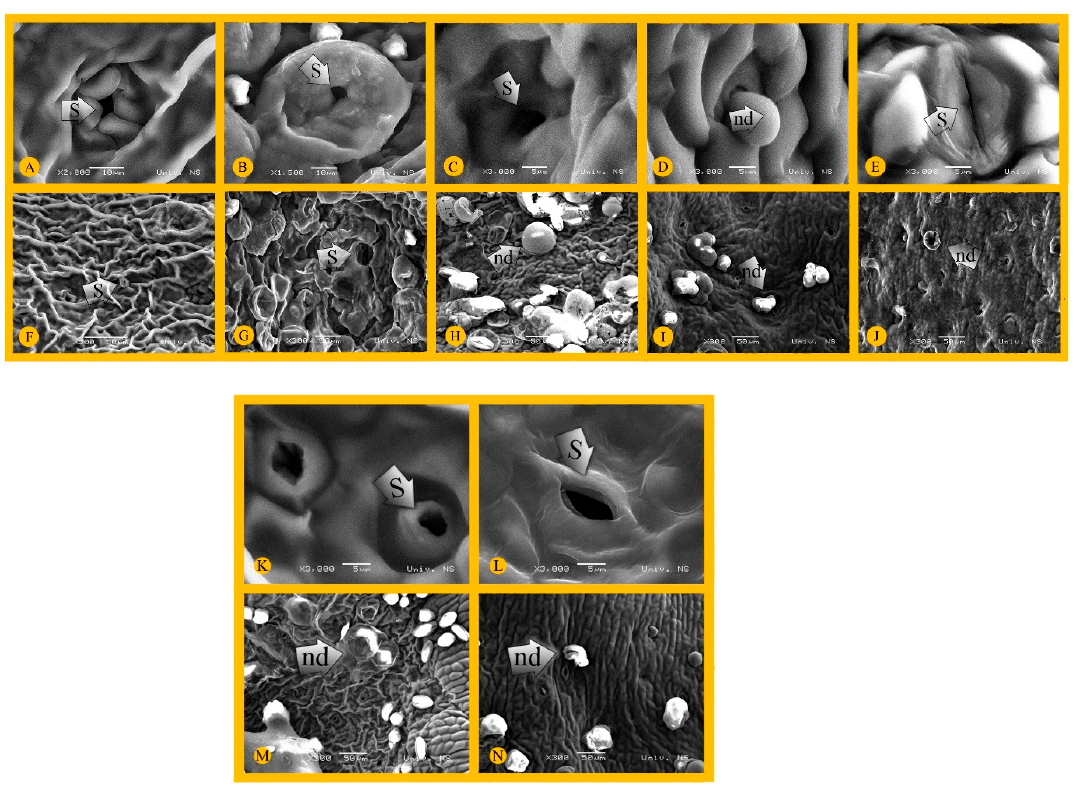
Figure 5. SEM micrographs of the nectary surface showing epidermis covered with cuticle focused on enlarged modified stomata in five cultivars comparatively: ( A , F ) Alexander Lucas (low susceptible), ( B , G ) Kieffer (highly resistant), ( C , H ) Nijisseiki (highly resistant); ( D , I ) Poire de Cure (moderately resistant); ( E , J ) Williams (susceptible); ( K , M ) Bella di guigno (moderately resistant); ( L , N ) Chojuro (resistant). ( A – E ) close-up of the mostly open stomata; ( B ) dried nectar droplet; nd—nectar droplet in the initial phase of secretion. ( F – J ) a larger area of glandular epidermis showing modified stomata and frequent nectar droplets imaged at different stages of secretion.